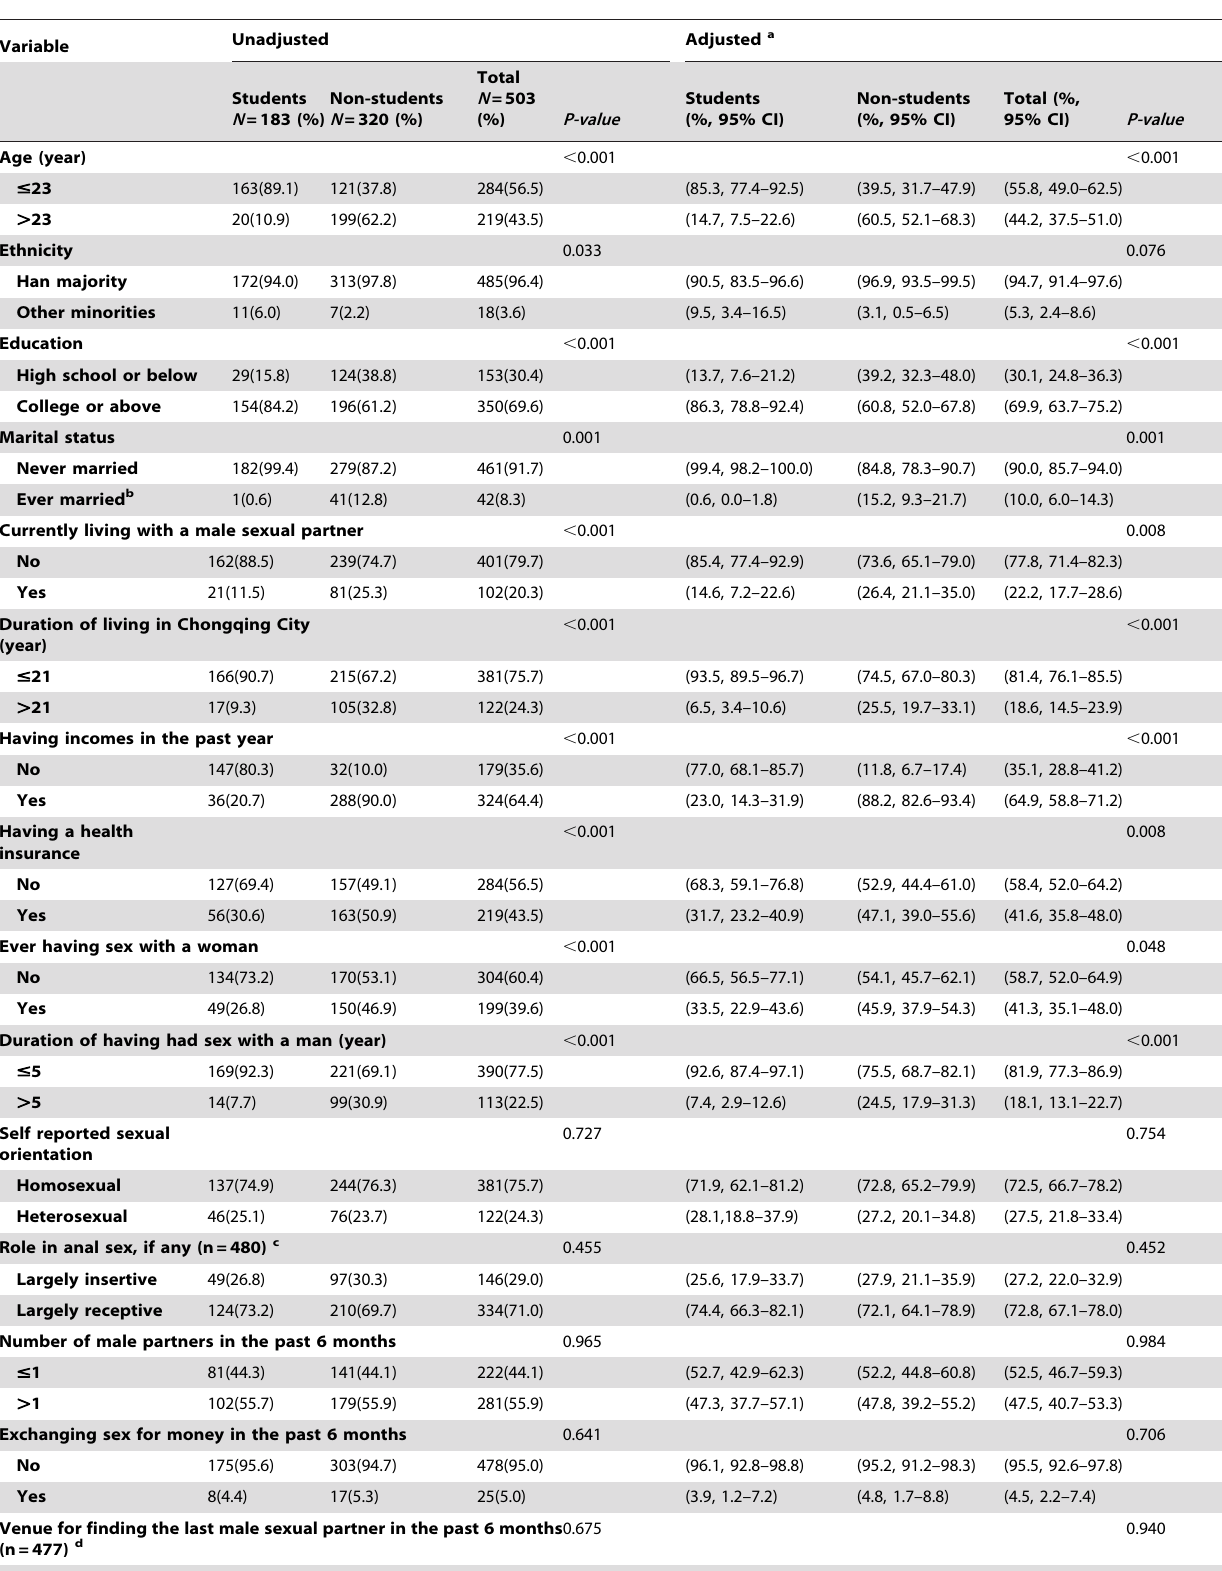
Table 1. Demographic and behavioral characteristics of 503 men who have sex with men in Chongqing City, China,